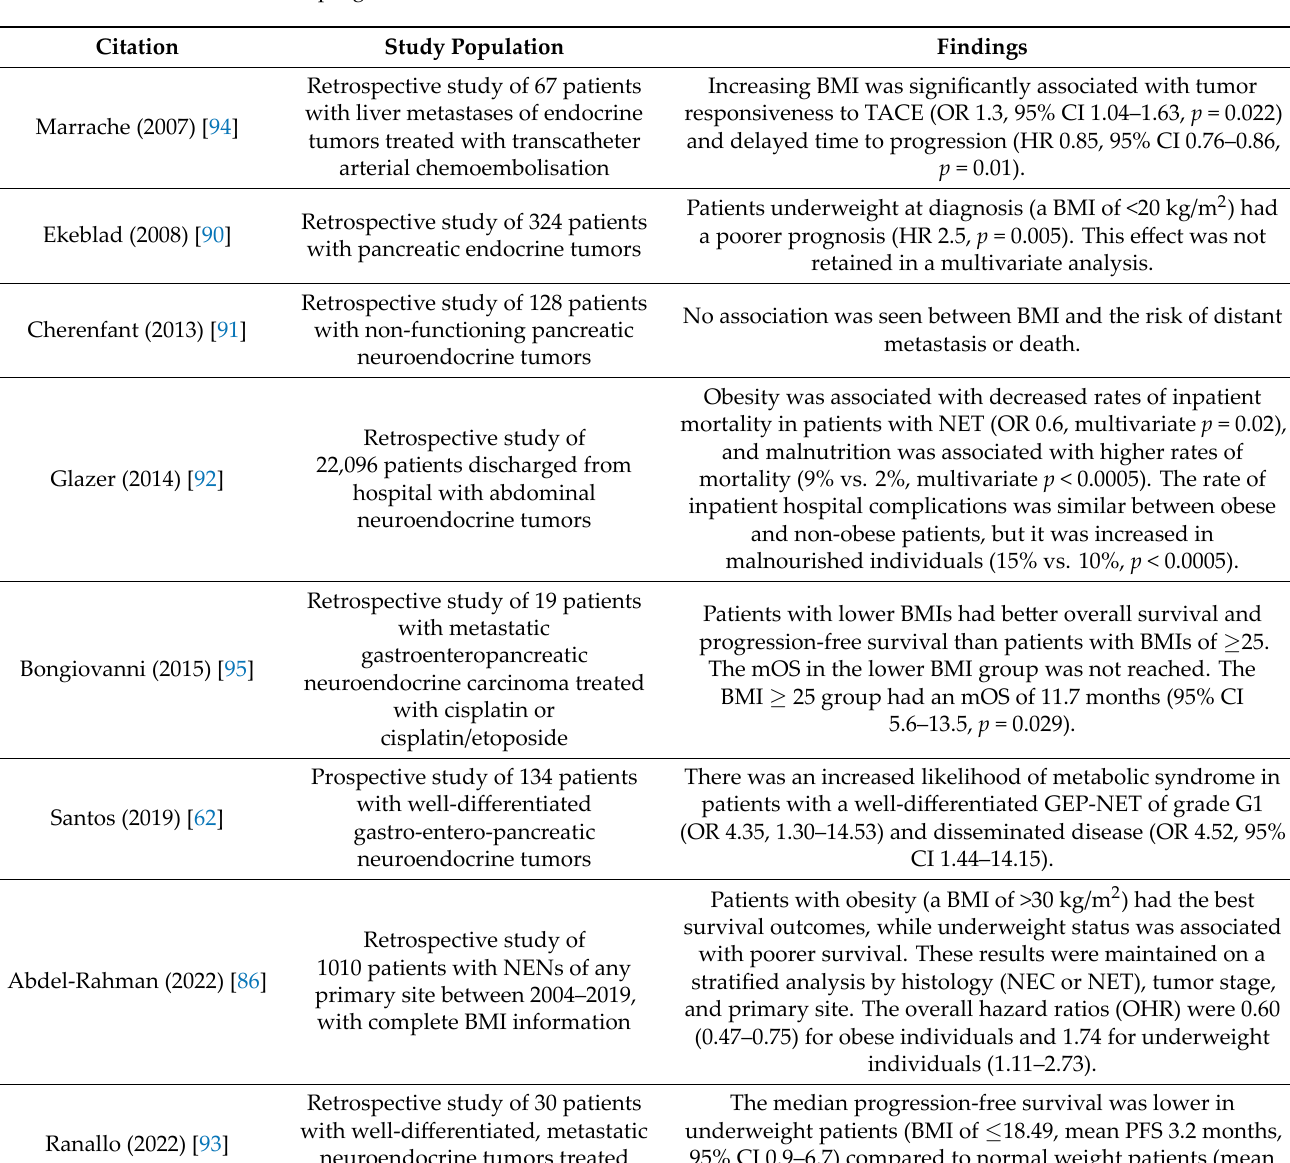
Table 2. Summary of the evidence examining the link between BMI and metabolic syndrome with a prognosis of neuroendocrine